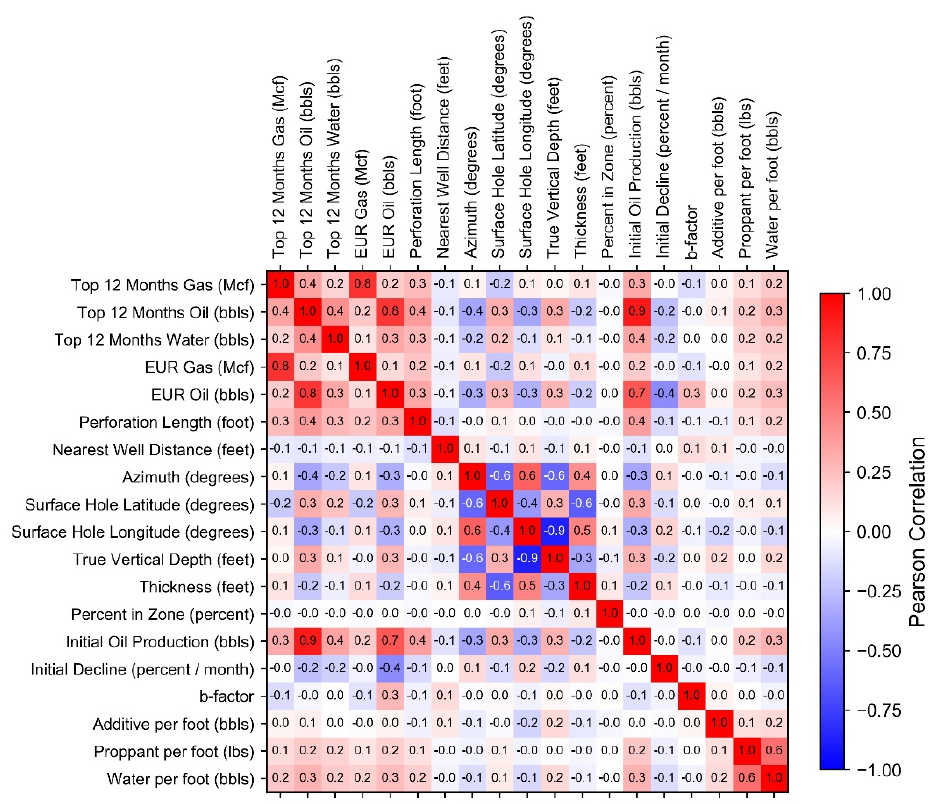
Figure 4. Pearson correlation matrix for the static dataset features evaluated.